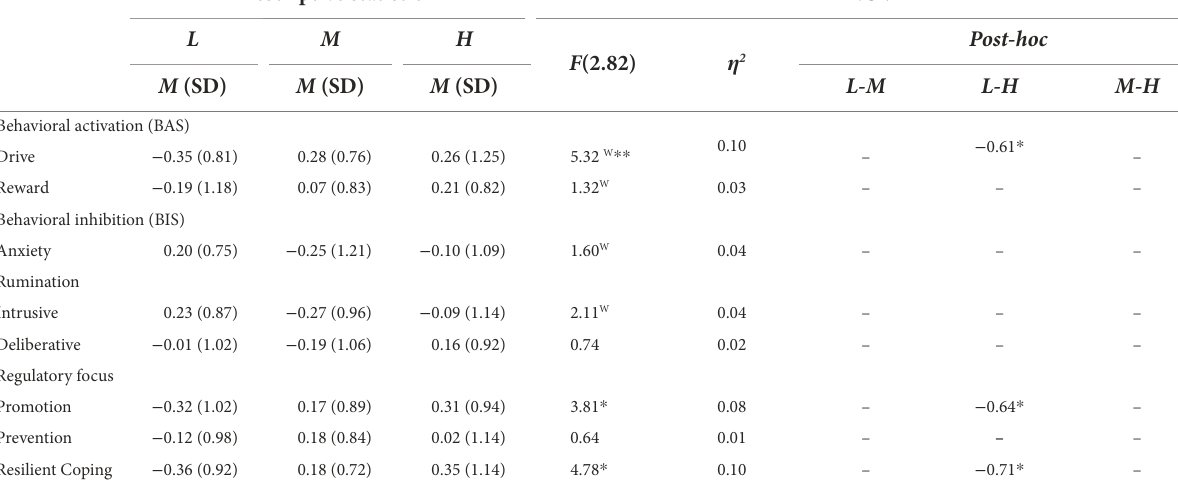
TABLE 2 ANOVA and post-hoc analyses comparing the variables according to the levels of PTG. Descriptive